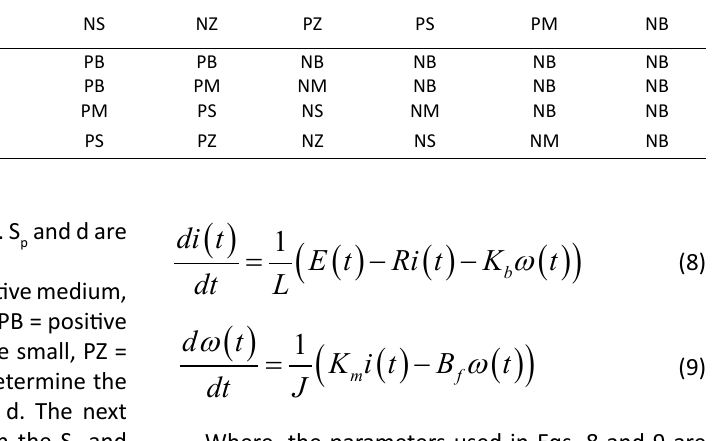
Table 1: The “and” relation between S p and d parameters